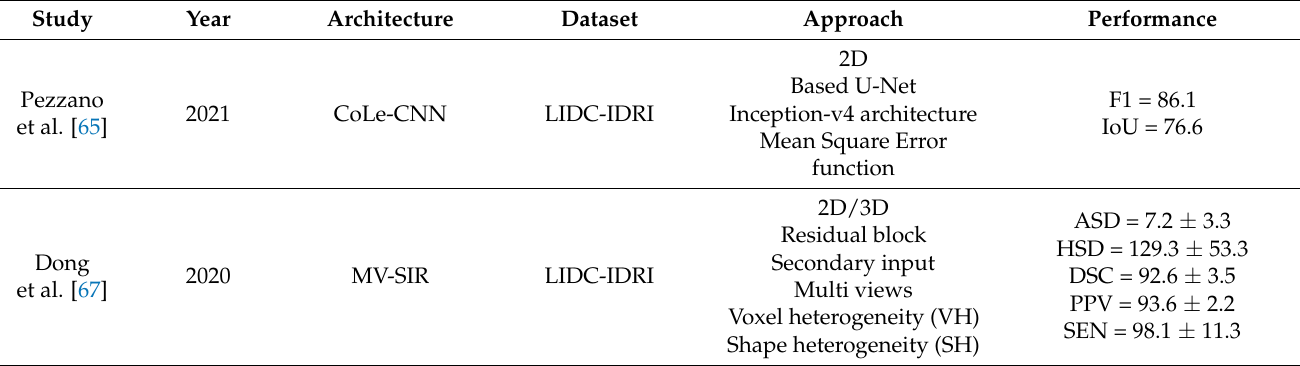
Table 3. Deep learning-based lung nodule segmentation architectures and their key